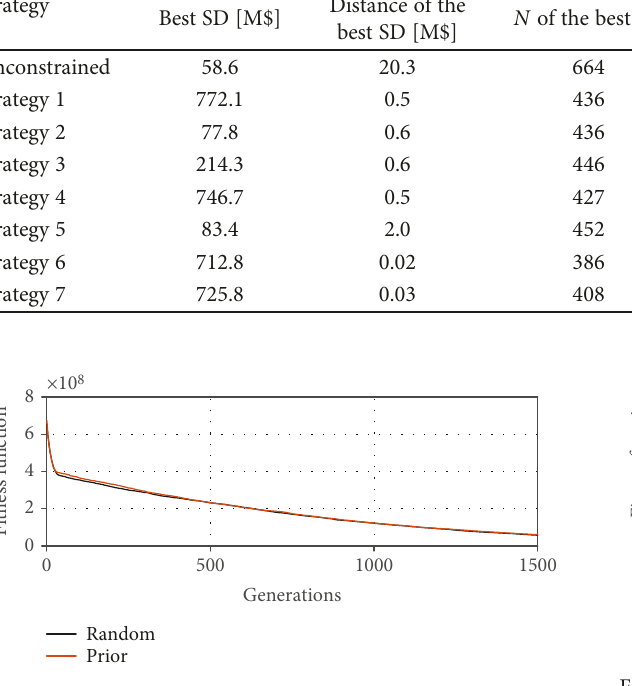
Figure 7: Evolution of the unconstrained fi tness function through generations.